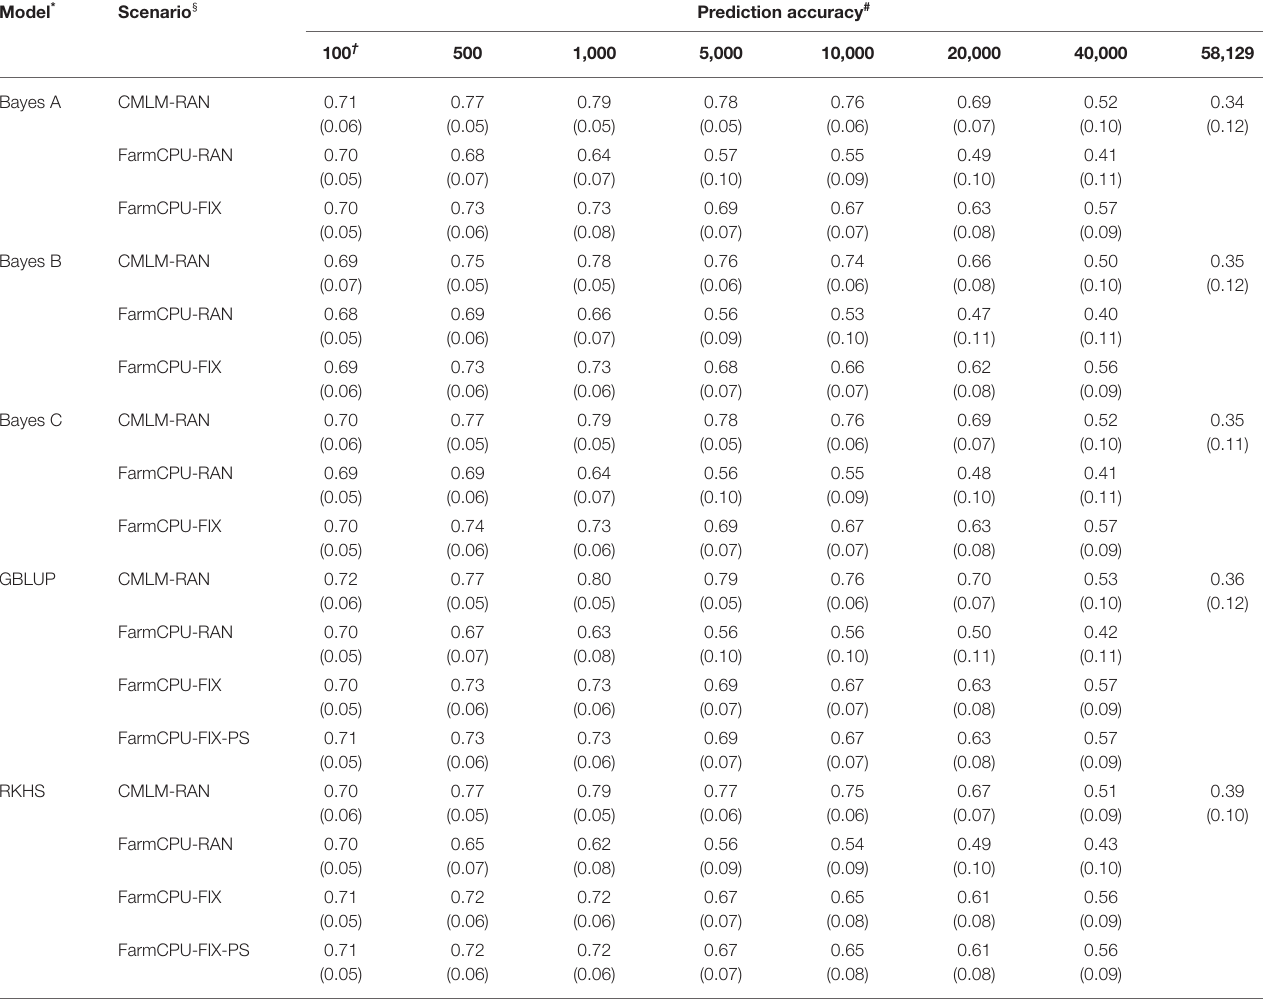
TABLE 5 | Prediction accuracy of random model, fixed model, and population structure model based on trait-associated markers in five prediction models for kernel row number. Model